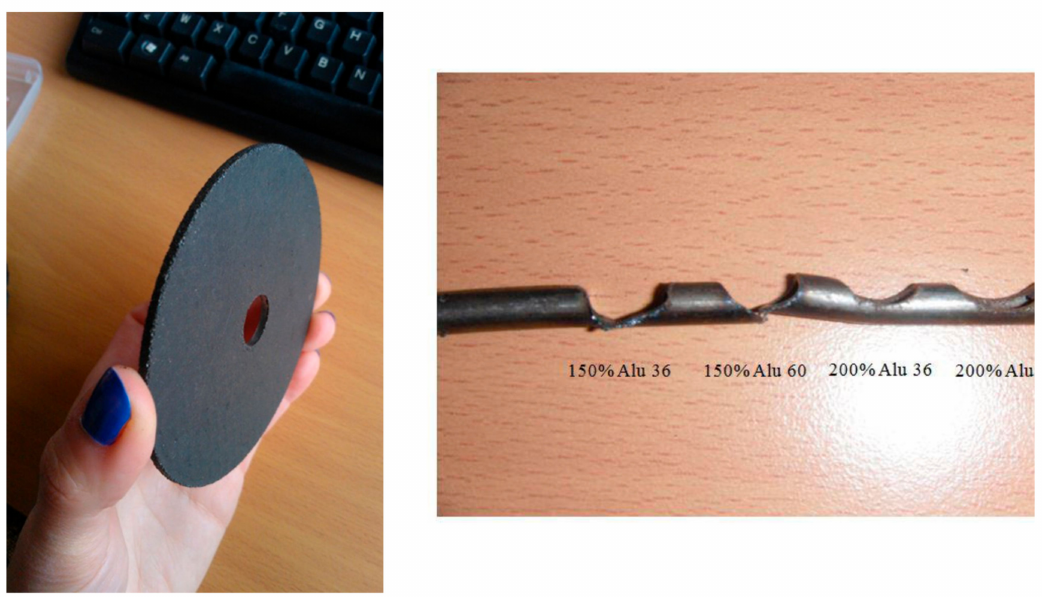
Figure 15. Example of an angle grinder disk using a tannin–furfuryl alcohol resin as a matrix, and example of cuts in a steel bar with it when using di ff erent